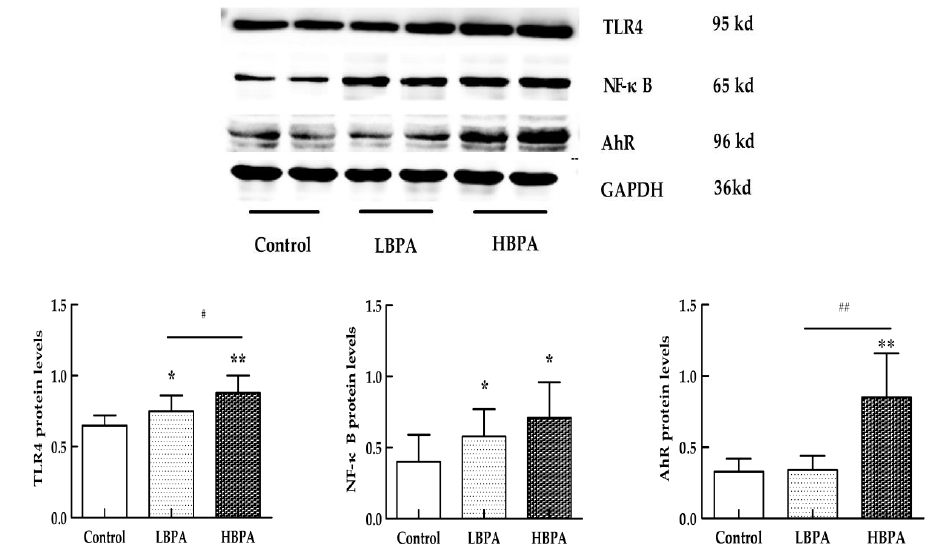
Figure 6. Effects of perinatal BPA exposure on the levels of Toll-like receptor 4 (TLR4), nuclear factor (NF)-κB, and aryl hydrocarbon receptor (AhR) protein expression in testis tissue in male offspring. Pregnant mice ( n = 7/group) were exposed to ethanol or BPA in water at levels of 0.2 μg/mL or 2 μg/mL from gestational day 6 through to the end of lactation. The levels of TLR4, NF-κB, and AhR protein expression in testis tissue were measured by Western blotting in male offspring. Values represent the means ± SE ( n = 7, one from each group). * p < 0.05 and ** p < 0.01 compared with controls. # p < 0.05 and ## p < 0.05 compared with the LBPA group.